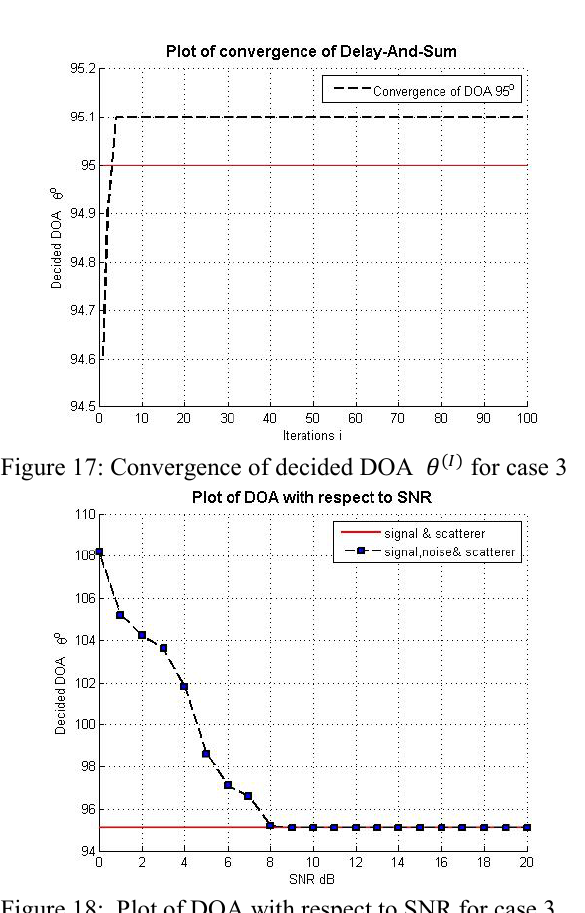
Figure 18: Plot of DOA with respect to SNR for case 3